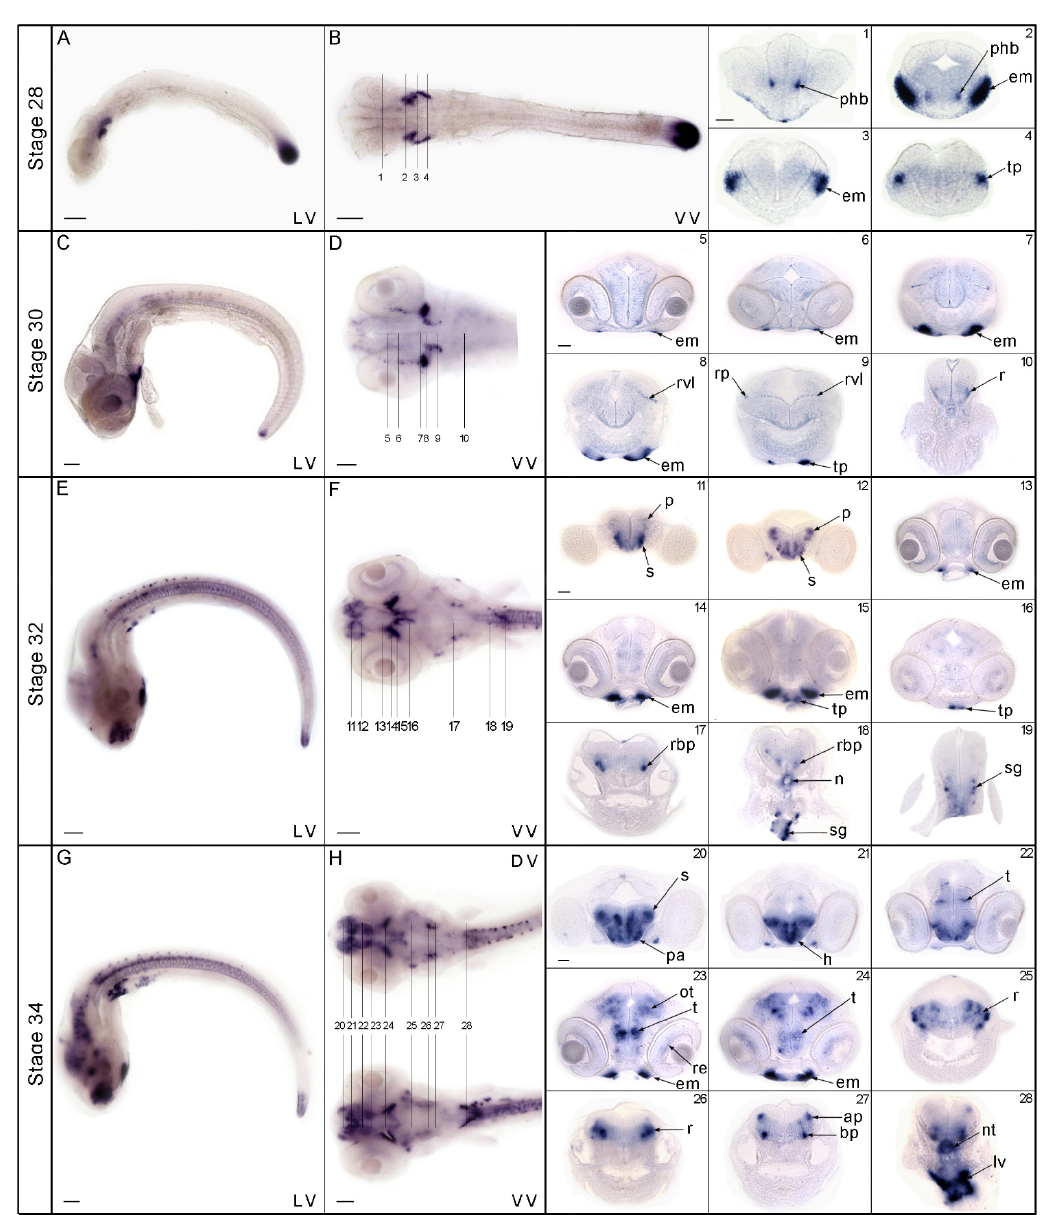
Figure 2. Expression of nos1 in medaka embryos and larvae. At stage 28, whole-mount in situ hybridization experiments displayed positive cells in the rostral portion of the nervous system and in the tailbud ( A , B ). At this stage, sections showed signal around the diencephalon-hypothalamus boundary (1–2), in the extraocular muscle (2–3), and caudally in the thyroid primordium (4). At stage 30 ( C , D ), expression was retained in the extraocular muscle and thyroid primordium, (5 to 9) and nos1 -positive cells were detected in ventricular layer cells of the rhombencephalon (8–9), be- tween the alar and basal plate (9), and in the rhombencephalic area (10). At stage 32 ( E , F ), nos1 was expressed in the subpallial and pallial region (11–12), in the extraocular muscle (13–15), and the